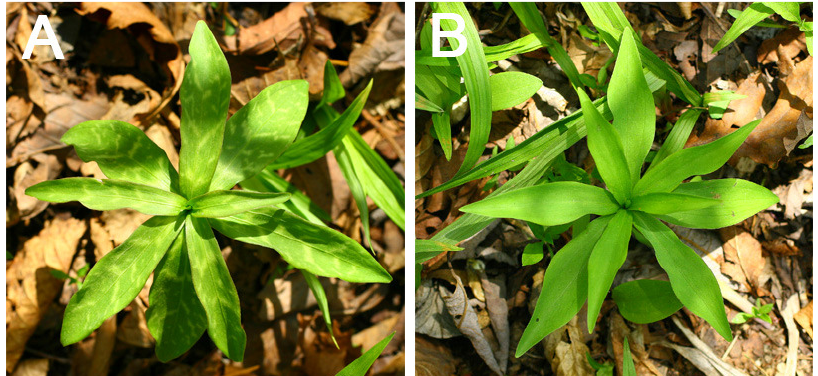
Z Mean ± standard error. Y Color indicated by RHS color chart